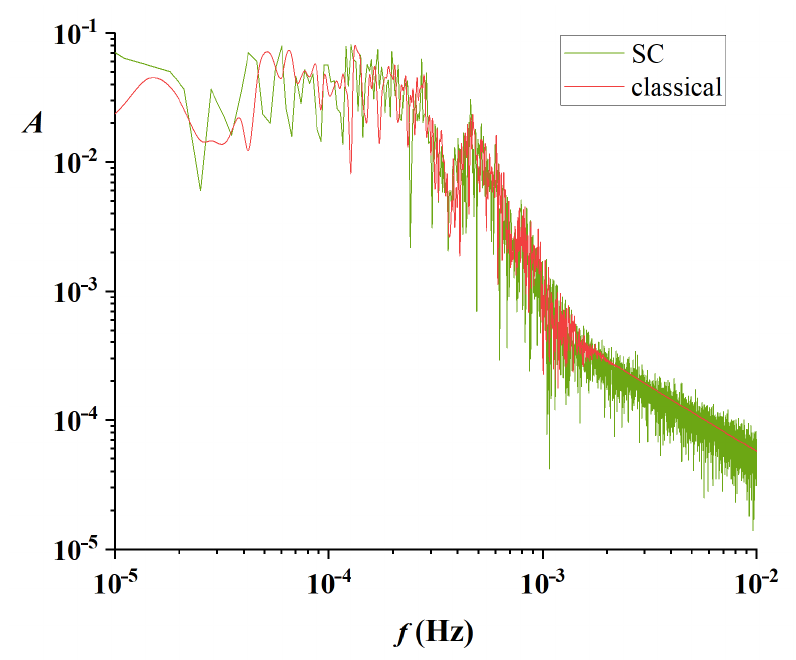
Figure 11. Power Spectra obtained from the Z ( t ) time series using the SC (green) and classical (red) integration